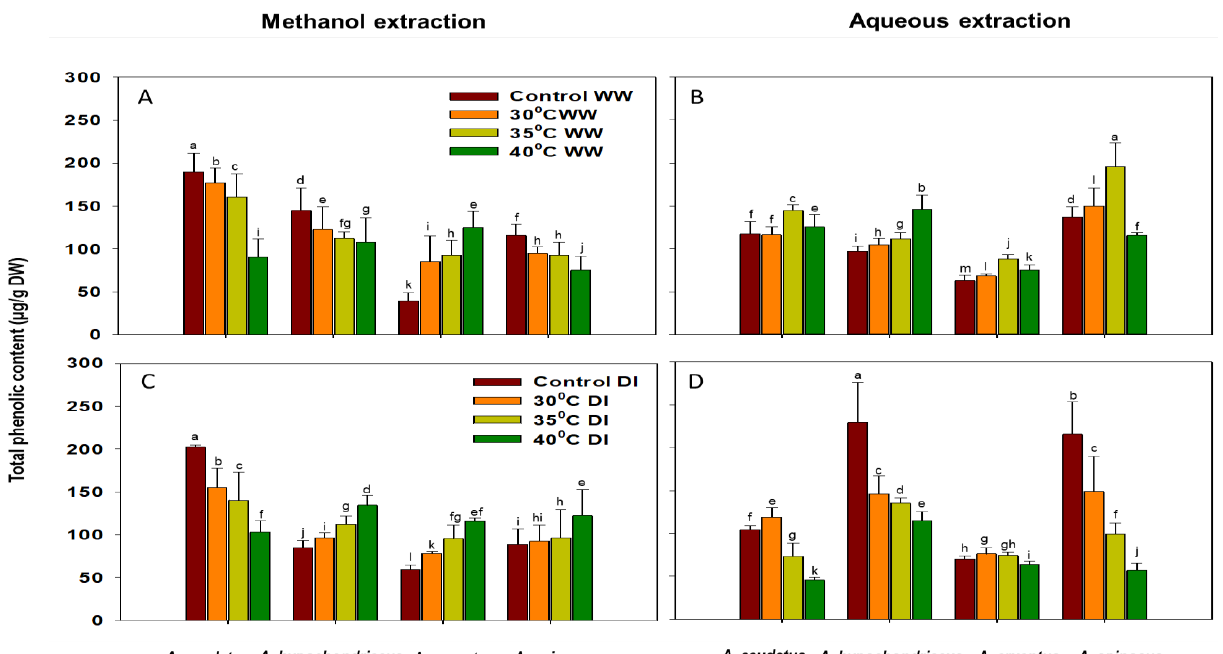
value, and vertical line is a mean standard error (±) at 95% confidence level. Values among each species with the same letter(s) are not significantly different at p ≤ 0.05.